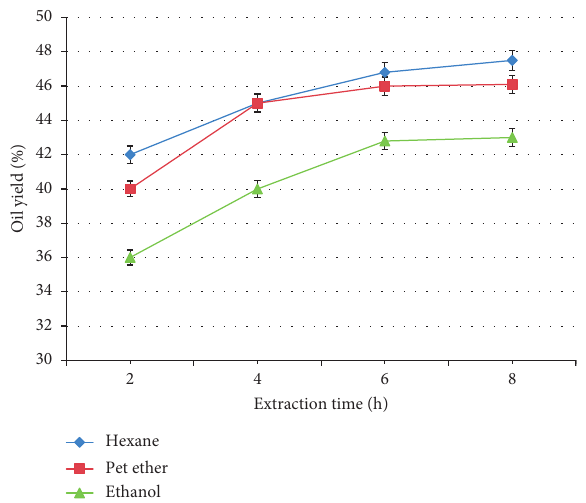
Figure 3: Effect of extraction time on oil recovery; extraction temperature 70 ° C.